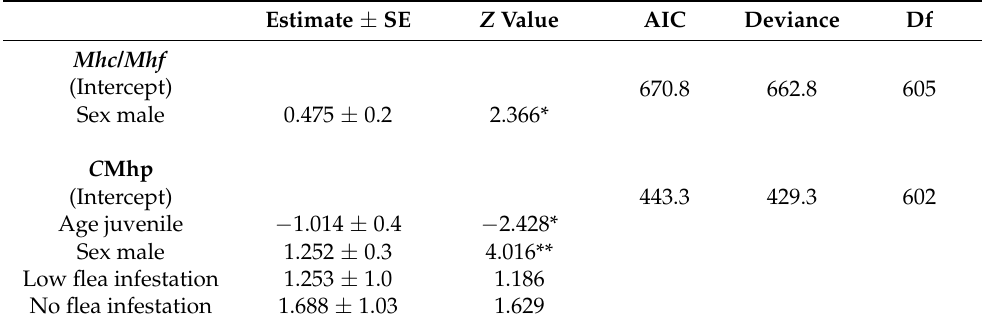
Table 4. Best GLMM representing multivariate relationships between predictor variables and detec- tion of Mycoplasma haemocanis/Mycoplasma haemofelis and Candidatus Mycoplasma haematoparvum in free-ranging rural dogs.